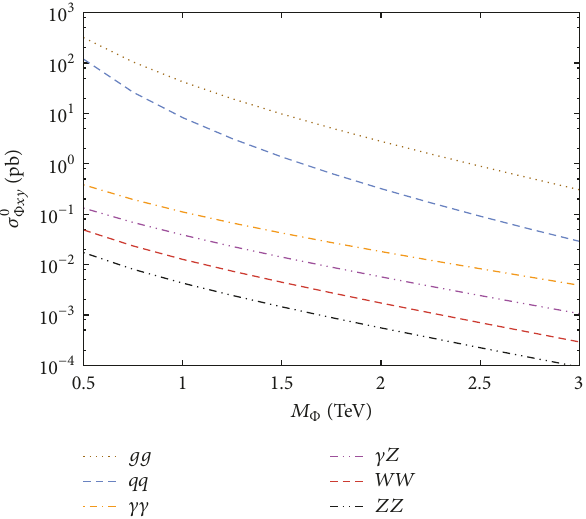
Figure 1: Partonic cross sections of various production modes of Φ as functions of 𝑀 𝜇 = 𝜇 = 𝑀 Φ computed at 𝑅 𝐹 Φ at the 13TeV LHC. Here, 𝜎 0 Φ𝑥𝑦 denotes the cross section of Φ produced through the 𝑥𝑦 fusion with 𝜅 𝑥𝑦 = 1 and Λ = 1 TeV. Initial 𝑔 , 𝑞 , and 𝛾 come from the PDFs of proton whereas initial 𝑊 and 𝑍 come from initial quarks. These cross sections are computed by applying some basic generation level cuts as defined in